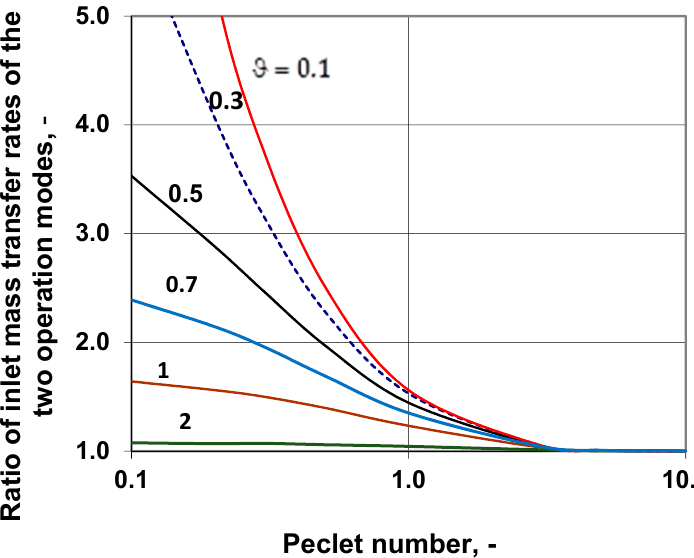
Figure 6. The inlet mass transfer rates, predicted by Equations (A2) and (A14), using the sweeping phase related to that obtained without a sweeping phase, in the case of a first-order reaction, as a function of the Pe -number by applying constant transport parameters.